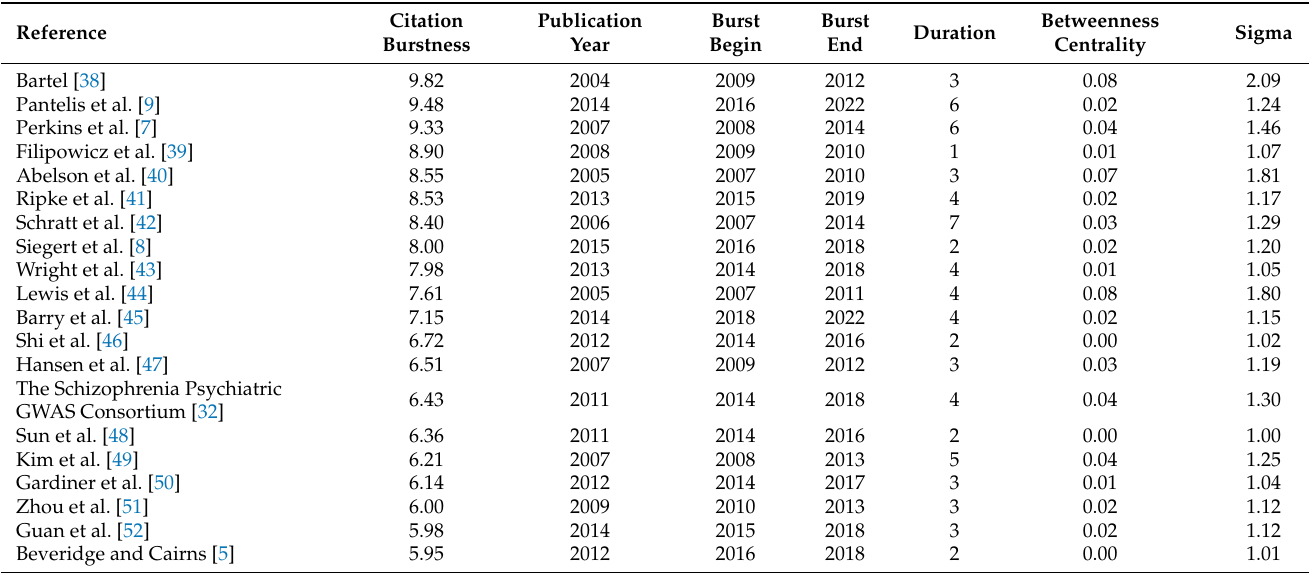
Table 2. Top 20 unique documents with highest citation bursts. Statistics are rounded to two decimal